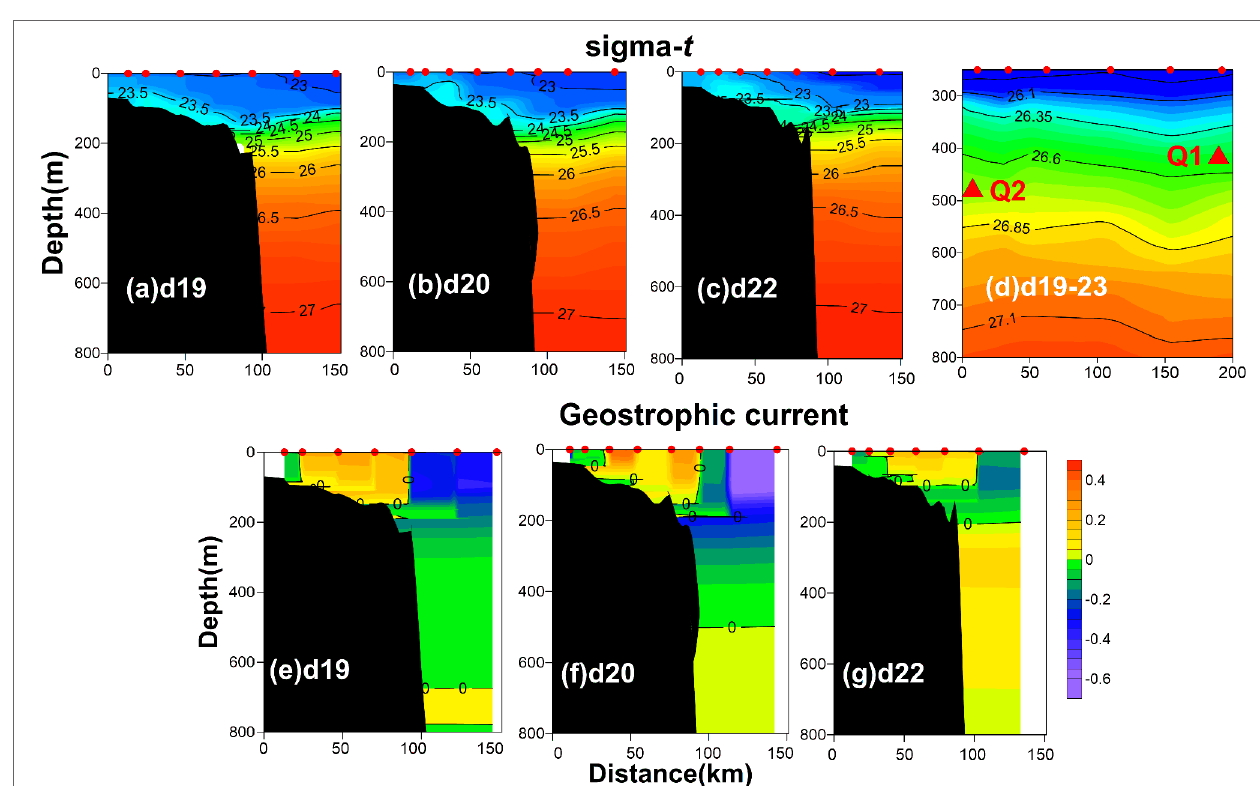
FIGURE 6 | Distribution of the potential density sigma-t (kg m -3 ) (A–C) and geostrophic current (m s -1 ) (E–G) on cross-slope transects d19, d20, and d22; sigma-t along-slope transect d19-23 (only at depths from 200 to 800 m) (D) . Note that the geostrophic current is referred to 1000 dbar; the along-slope transect is close to mooring stations Q1 and Q2 (red triangles). The accompanying CTD castings (red dots) at the stations were performed on days 19, 20, 22 and